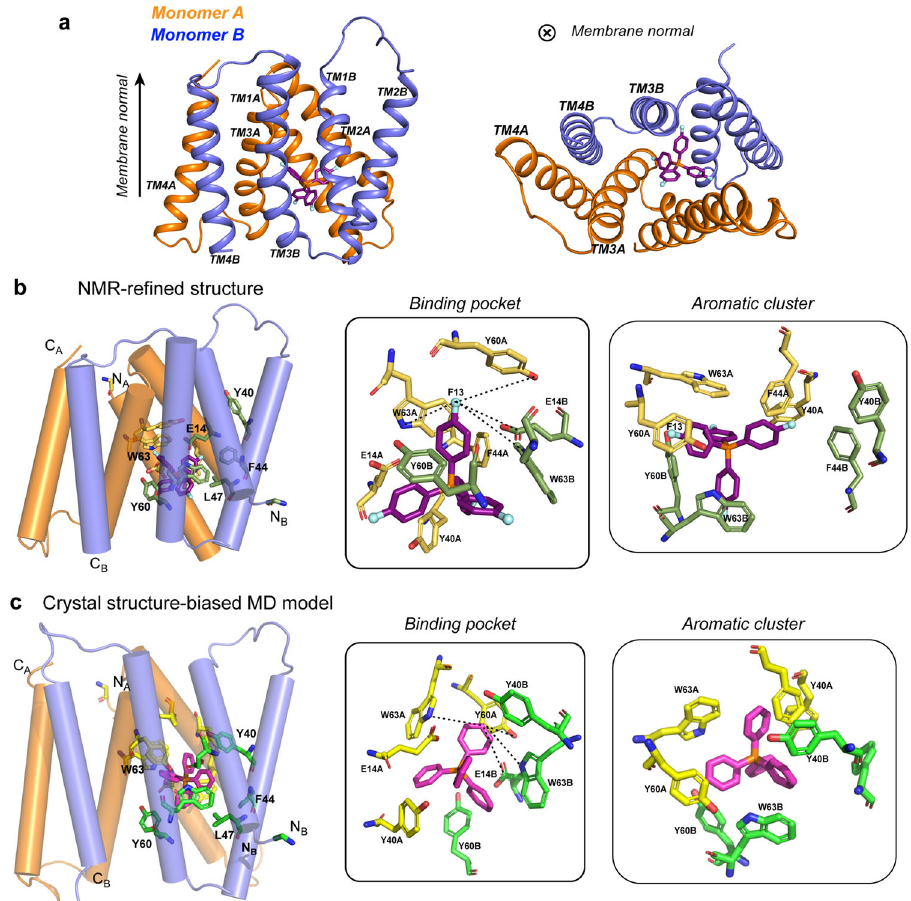
Fig. 5 Experimentally determined structural model of the EmrE-TPP + complex in DMPC bilayers at low pH. a . Side view (left) and bottom view (right) of the substrate-EmrE complex. The ligand (purple) lies closer to monomer A (orange) than monomer B (blue). b Distance-constrained NMR structure model of the drug-binding site. Key residues, including E14, Y40, Y60, and W63, surround the substrate (middle). One of the four phenylene H ζ atoms, marked as F13, is tightly coordinated by residues from both monomer A (yellow) and monomer B (green). The right panel shows a bottom view of all aromatic residues (W63, Y60, F44, and Y40) surrounding the substrate. Monomer A residues are colored in yellow while monomer B residues are colored in green. c Crystal structure biased MD-simulated structure model of TPP-bound EmrE. The substrate position and orientation relative to the binding-site residues differ from those in the experimental NMR structure. Monomer A residues are shown in yellow and monomer B residues are shown in green.